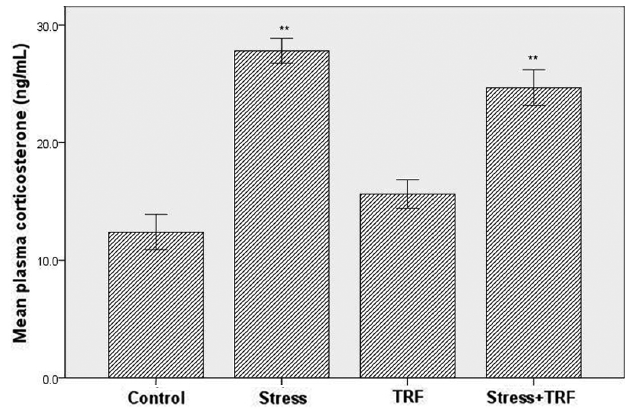
FIGURE 1 – Effects of strees, tocotrienol rich fraction (TRF) supplementation and combination of stress and TRF on the plasma corticosterol level. Value represents mean ± SEM. **indicates significantly different from the control at p <